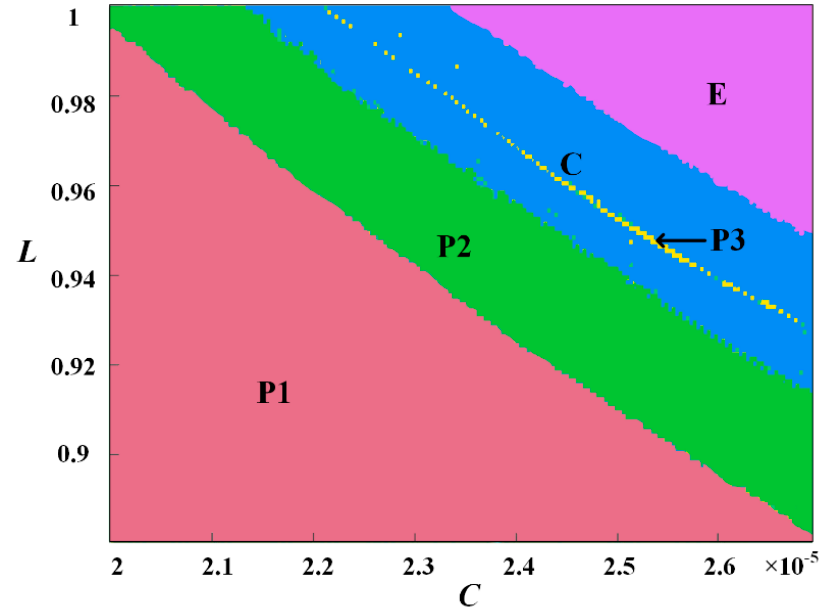
Figure 23. Dynamic map with V = 0.1031